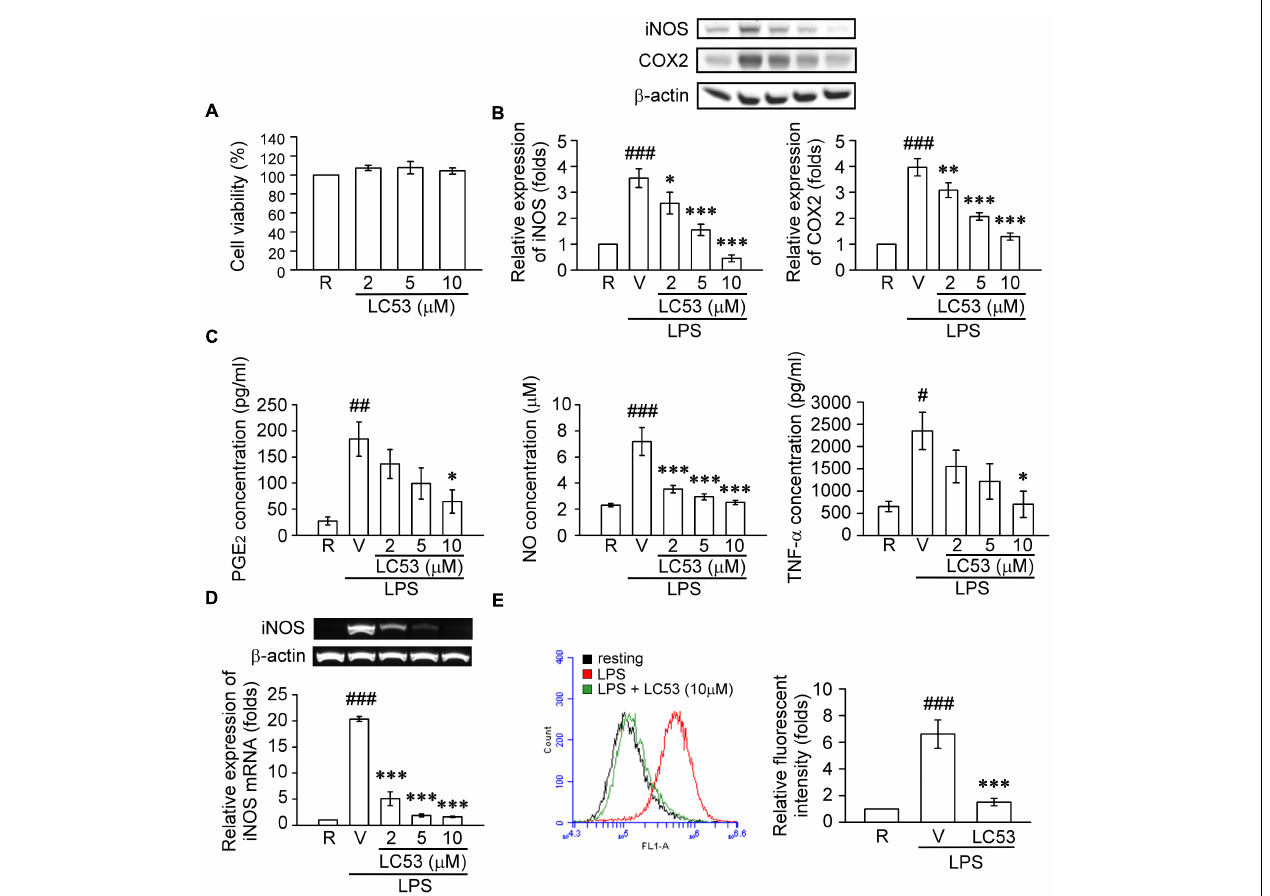
FIGURE 5 | LC53 inhibited the productions of inflammatory enzymes and mediators in LPS-stimulated microglial BV2 cells. BV2 cells were pretreated with the vehicle (DMSO) or LC53 (2, 5, and/or 10 µ M) for 30 min and stimulated with LPS (150 ng/ml) for indicated time. (A) Colorimetric MTT assay was used to measure BV-2 cell viability after LC53 incubation for 24 h. The percentage of the absorbance was compared to the resting group treated with DMSO. (B) Protein level of iNOS and COX-2 in cell lysates were examined 24 h after LPS-stimulation using Western blot. (C) The PGE 2 , NO and TNF- α level of supernatants from cultured BV-2 microglial cells were evaluated 24 h after LPS-stimulation by ELISA or nitrate/nitrite colorimetric assay kit. (D) Expression of iNOS mRNA was evaluated 6 h after LPS stimulation by RT-PCR analysis. β -actin was used as internal control. (E) After LPS-stimulation for 24 h, BV-2 microglial cells were incubated with DCFH-DA for 40 min. Then the DCF fluorescent intensities were analyzed by flow cytometry. The results were analyzed from 3 to 6 independent experiments and presented as the mean ± SEM. R, resting; V, vehicle (DMSO). # p < 0.05, ## p < 0.01, ### p < 0.001 compared with the resting group; ∗ p < 0.05, ∗∗ p < 0.01, ∗∗∗ p < 0.001 compared with the LPS-stimulated group treated with